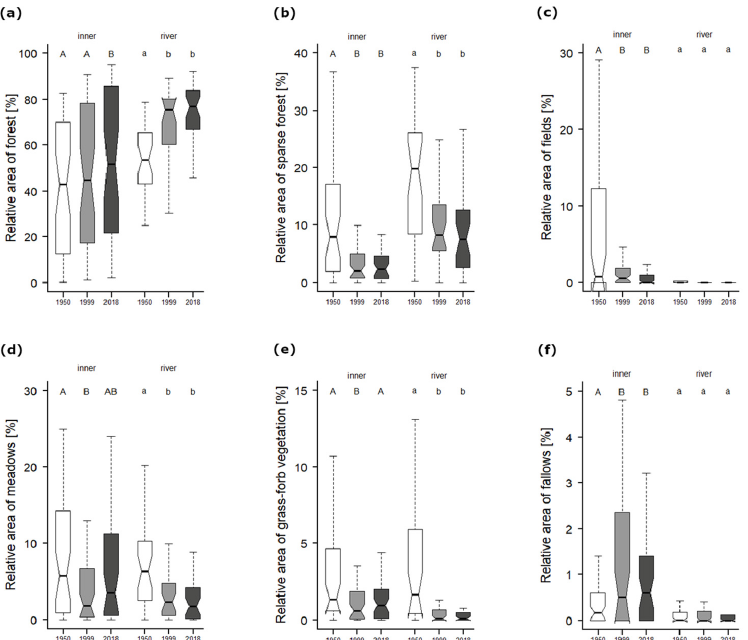
Figure 2. Changes in the relative areas (percentages of the whole grid cell area) of ( a ) forest, ( b )